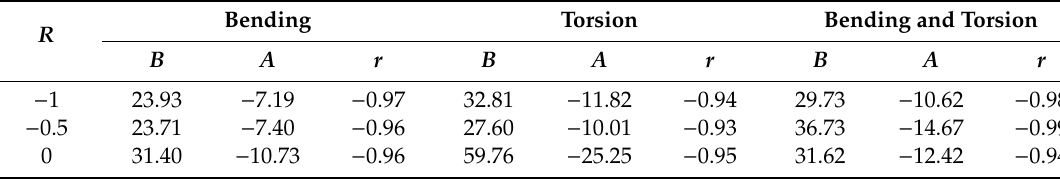
Table 3. Parameters of the regression equation.